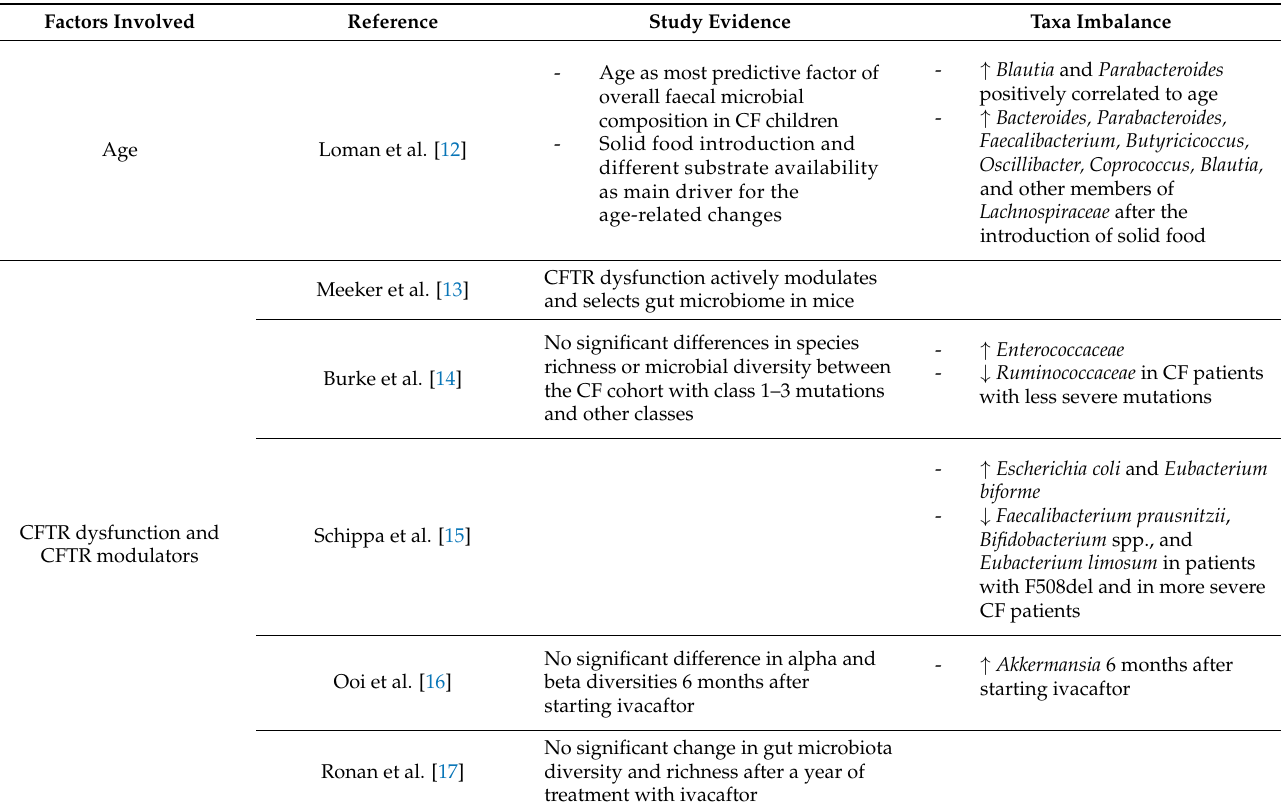
Table 1. Evidence on factors influencing microbial acquisition and